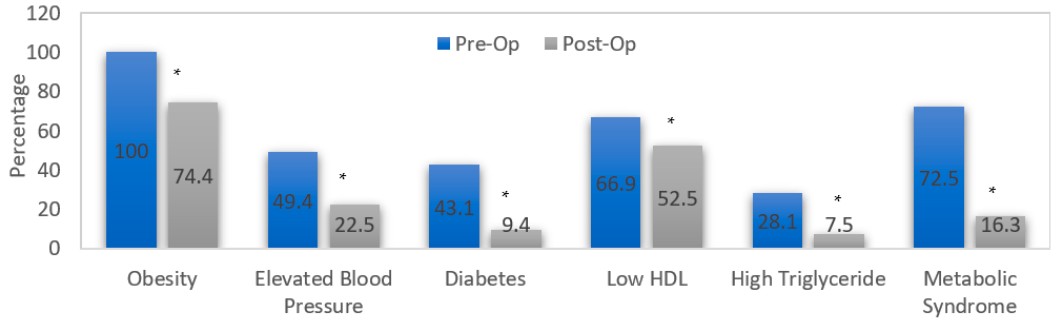
Figure 4. Comparison in the presence of MetS components pre-op and 12 months post-op. * Signif- icant difference when comparing with the preoperative value at p ≤ 0.001.